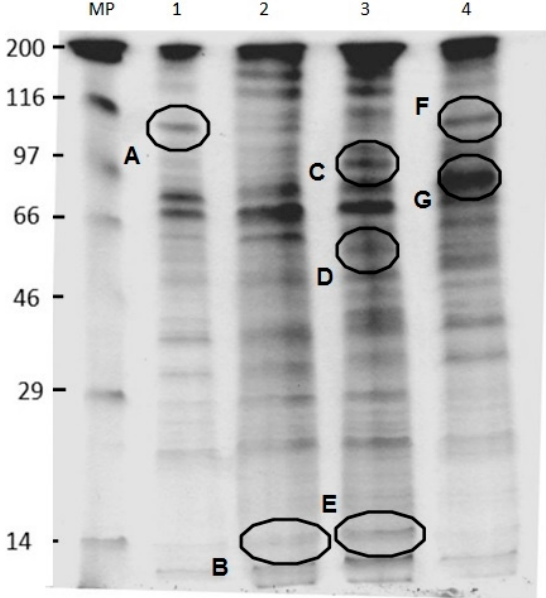
Figure 5. SDS-PAGE of the membrane fraction of U. maydis after the different antifungal treatments. Oligochitosan and glycol–chitosan were added at 1 mg · mL − 1 . Chitosan was added at 10 µg · mL − 1 due to the effect on cell growth. MW= Molecular weight marker (KDa); 1 = Control cell without antifungals; 2 = Cells treated with chitosan; 3 = Cells treated with oligochitosan; 4 = Cells treated with glycol–chitosan. Squares indicate differences in the bands pattern.